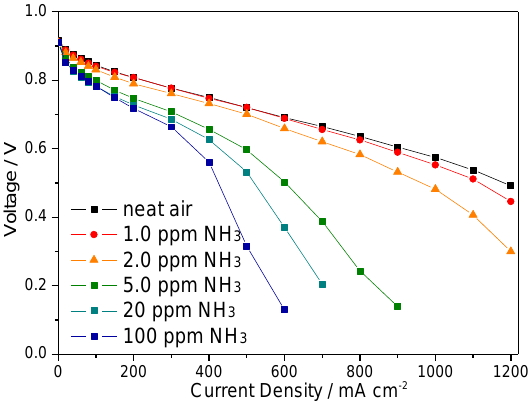
Figure 4. Effects of NH 3 in air on polarization.